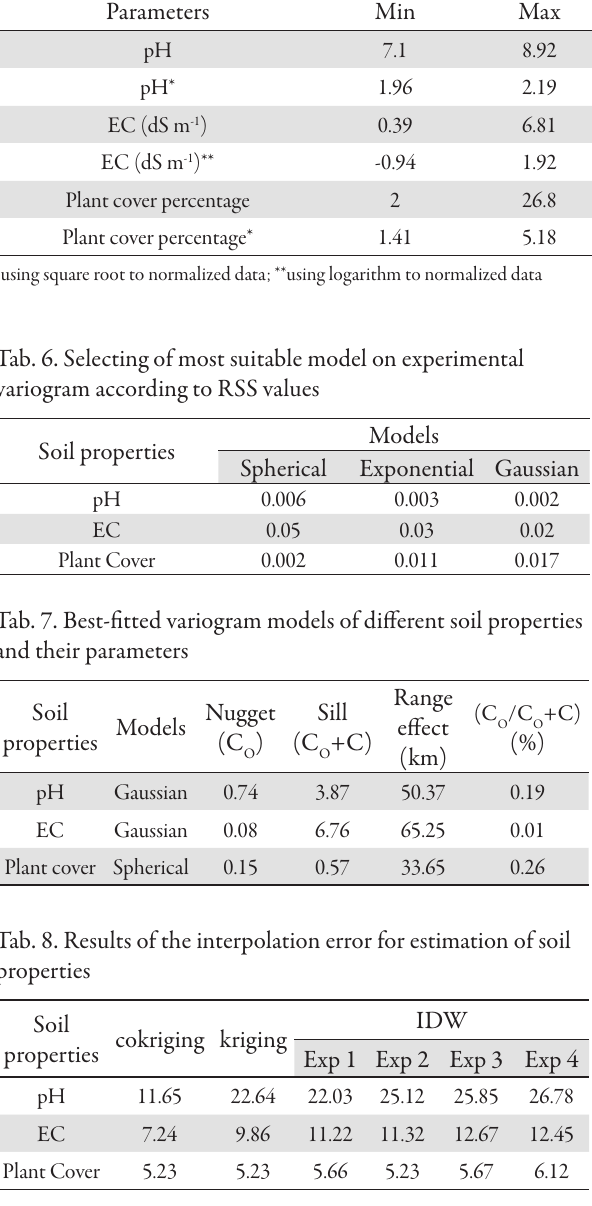
Tab. 5. Summary of statistical analysis on studied parameters Parameters